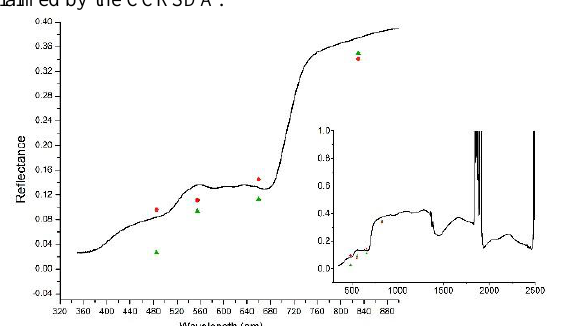
Figure.8 The comparision of 𝜌 𝑐 for a specific sample area